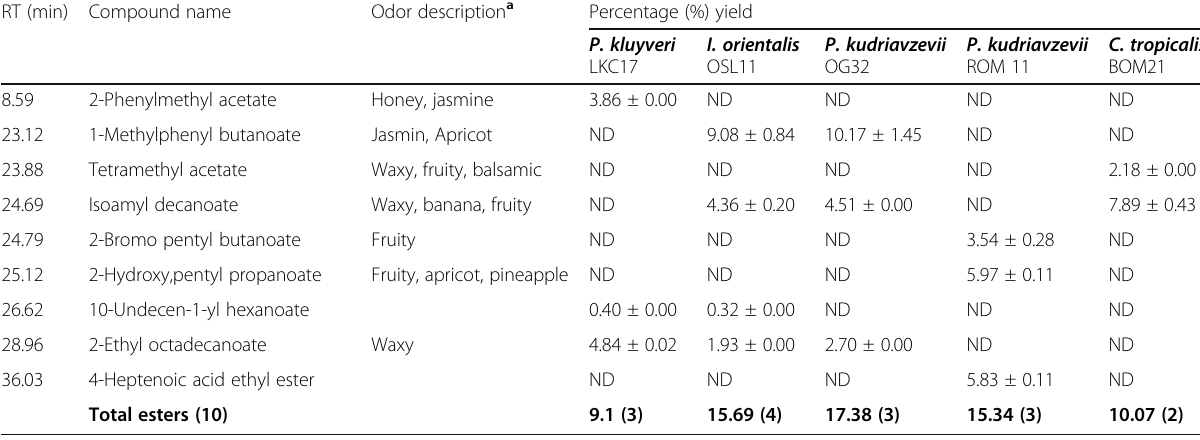
Table 1 Analysis of volatile compounds produced by probiotic yeast strains (Continued)